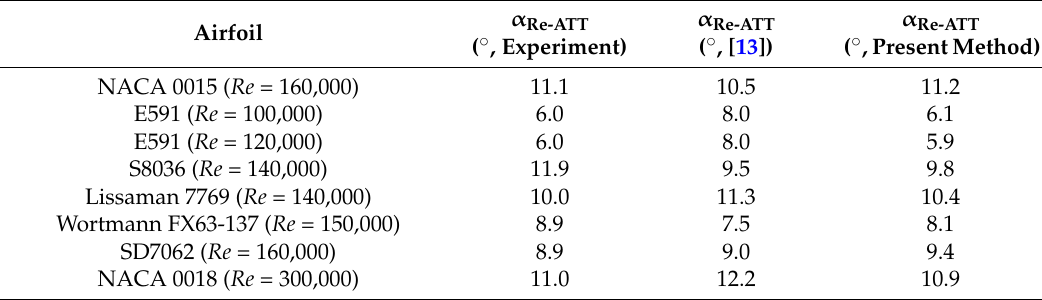
Table 1. Comparison between experiment and theory; prediction of α Re-ATT